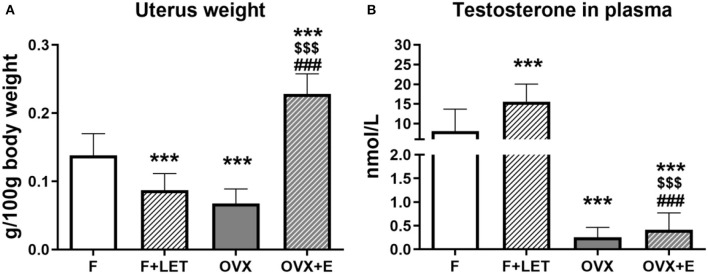
Uterus weight adjusted to body weight (A) and testosterone concentration in plasma (B). Data are presented as mean + SD. ***p < 0.001 in comparison to F group, $$$p < 0.001 in comparison to F + LET group, ###p < 0.001 in comparison to OVX group; n = 9–11/group; F, females; F + LET, letrozole-treated females; OVX, ovariectomized females; OVX + E, estradiol-treated ovariectomized females.